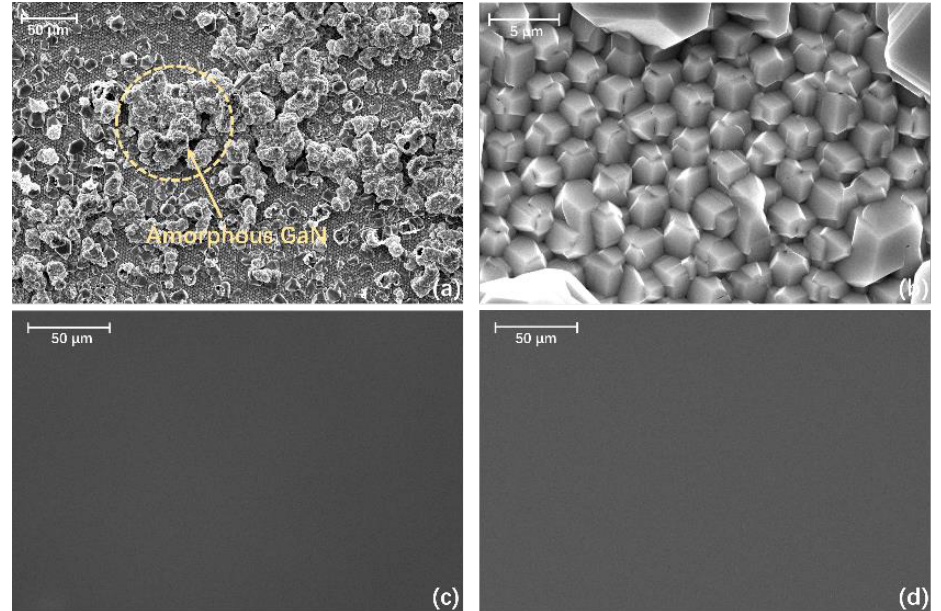
Figure 4. ( a )The top-view SEM images of the GaN film on the 10 nm sputtered AlON/PSS template and ( b ) a partly magnified top-view SEM image. Smooth morphology of GaN films on ( c ) the 25 nm and ( d ) 40 nm sputtered AlON/PSS. GaN film on 10 nm sputtered AlN/PSS template does not coalesce well and some amorphous GaN appears. The morphology of the GaN on 25 nm and 40 nm sputtered AlN/PSS templates.